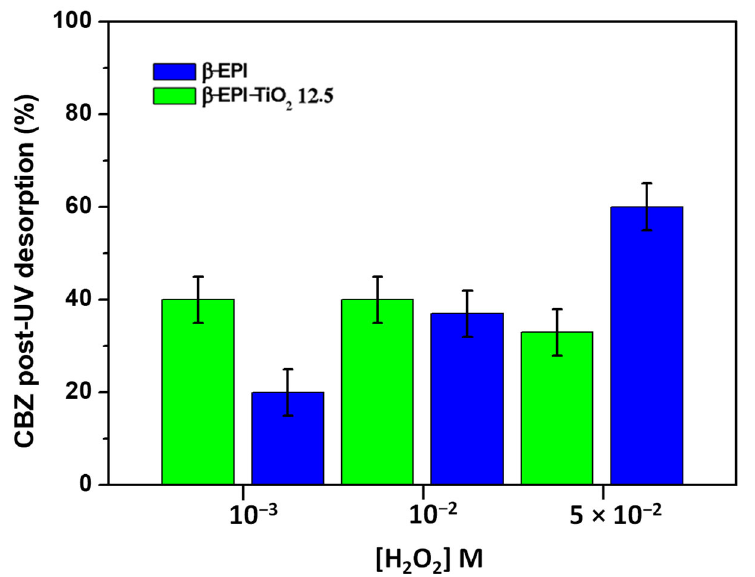
Figure 9. Histograms indicate desorption percentages of CBZ adsorbed onto β -EPI (blue bars) and β -EPI TiO 2 12.5 (green bars) UV light irradiation.